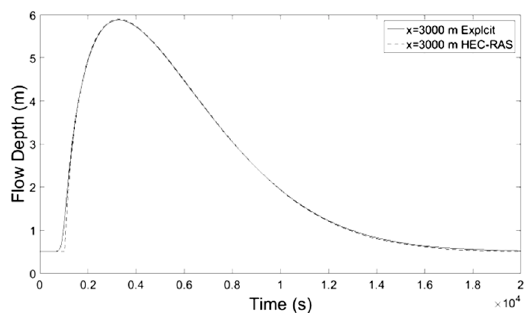
Figure 4. Flow Depth-Time at x = 3000 m.